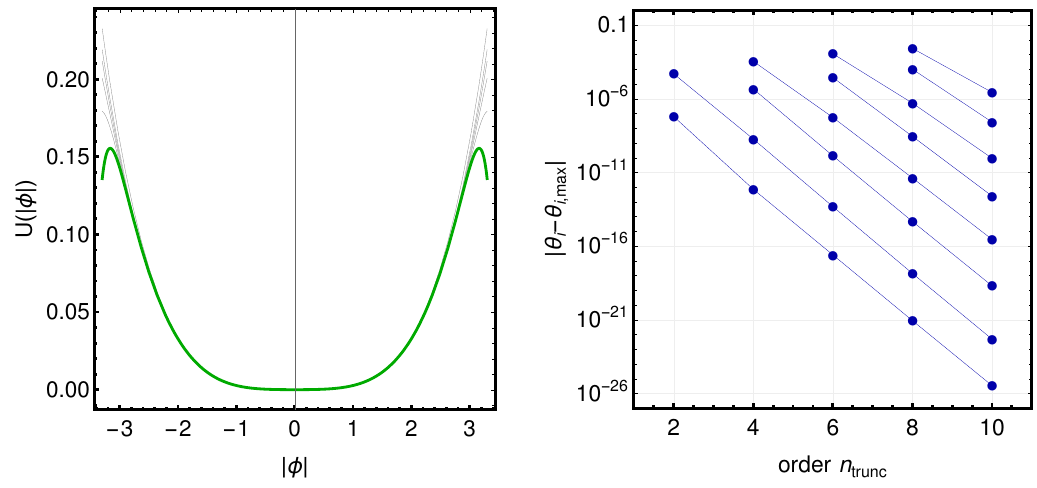
Figure 2 . Convergence of the scalar (cid:12)xed-point potential for A = 1 = 10, (cid:11) g = 0 and (cid:11) y = 1 = 100. Left-hand panel: stable scalar potential within the radius of convergence at order n trunc = 12 (thick green line) and at all lower orders (thin gray lines). Right-hand panel: apparent convergence of the 8 lowest order critical exponents (cid:18) i . For each (cid:18) i we show the absolute value of the di(cid:11)erence between the value at the present truncation order n trunc and at the highest truncation order n trunc ; max = 12, i.e., j (cid:18) i (cid:0) (cid:18) i,max j